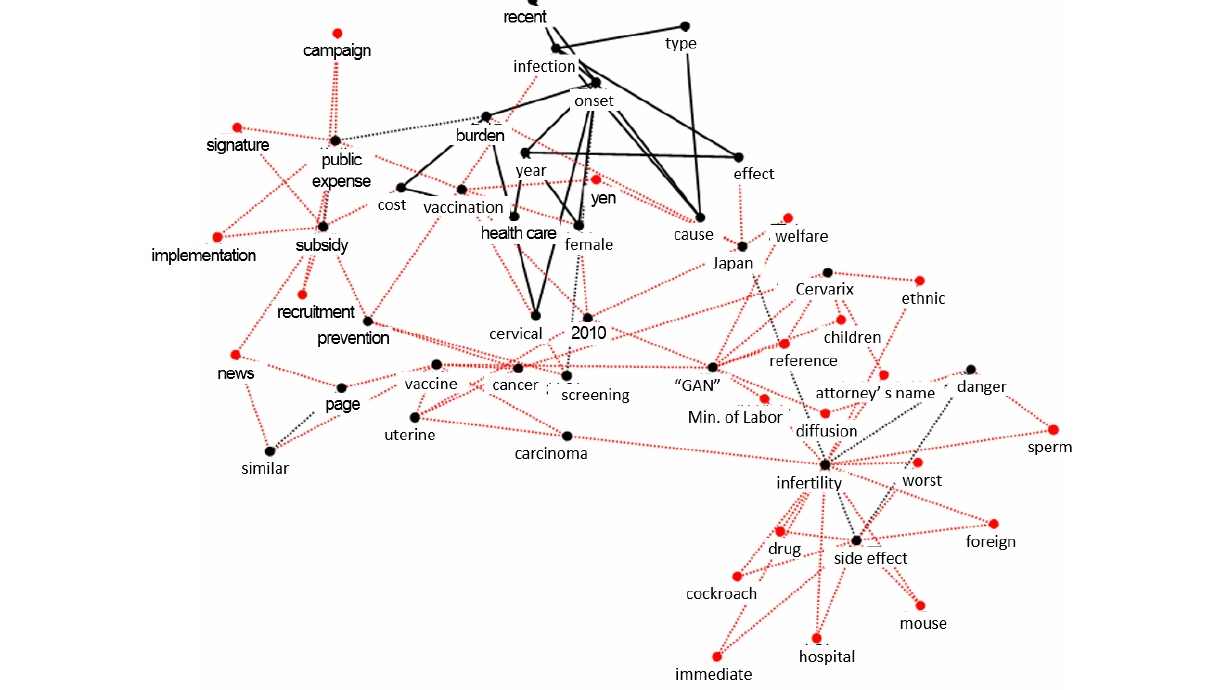
Figure 3. Keyword map (KeyGraph) showing the primary stakeholders in HPV vaccination in 2010. The most frequent words are shown with